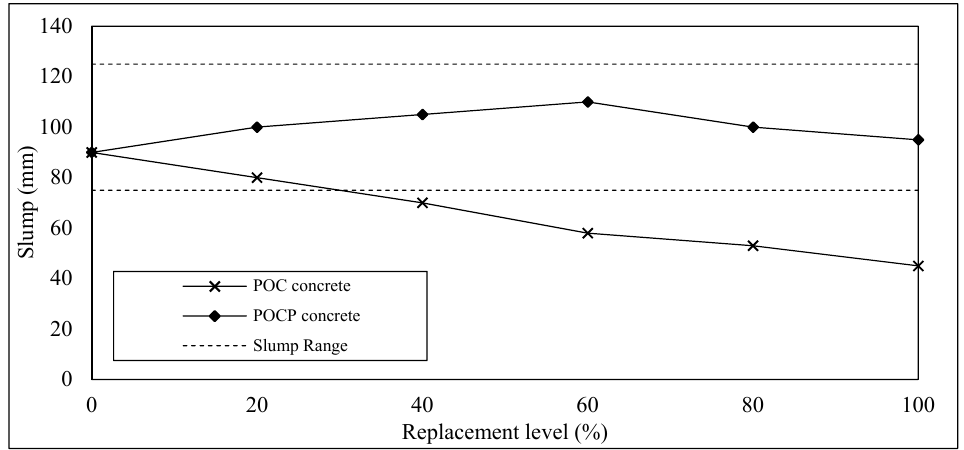
Figure 9. Slump values of POC and POCP concrete mixes.